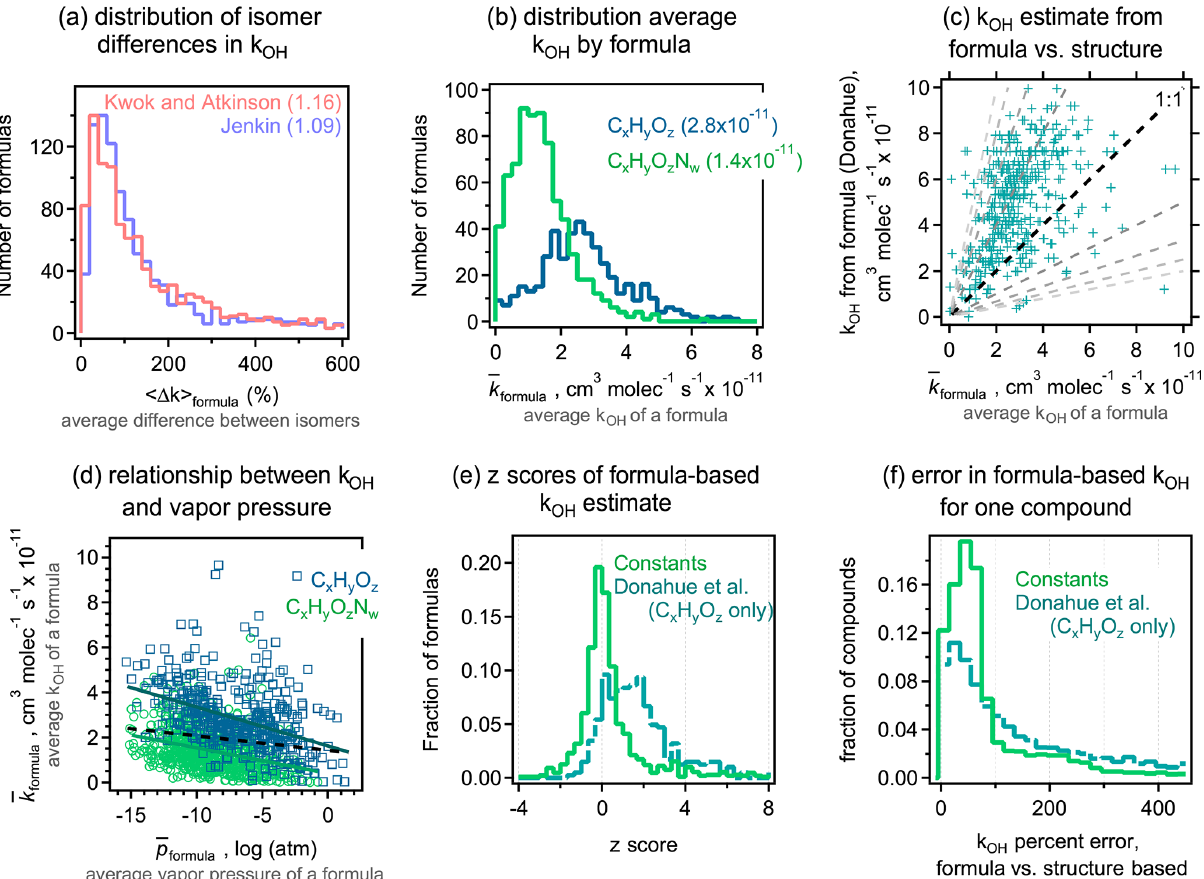
Figure 6. (a) Differences in k OH between isomers for the two structure-based estimation methods examined. (b) Distribution of k formula , which is the average k OH for a given formula calculated as the average of both methods for all isomers, shown separately for formulas with and without nitrogen, with the average value provided in parentheses. (c) Comparison of formula-based Donahue estimate to k formula ; dashed lines are 1 : 1, 1 : 2, 1 : 3, etc. (d) Comparison of average k OH ( k ) to average vapor pressure ( p formula ) for a given formula, separated into formulas with and without nitrogen. Trend lines ( R 2 is equal to 0.15) are shown in the same colors, with the trend line for the combined set ( R 2 is equal to 0.02) shown as a dashed black line. (e) Z scores of each formula-based method are calculated as described in Fig. 3 and the main text. (f) Distribution of error from applying this method to any given compound, with all oxidation system combined. In contrast to other figures, this shown in relative terms, as the number of compounds that do not contain nitrogen is a minority subset of the full data set and is thus obscured when shown with an absolute y